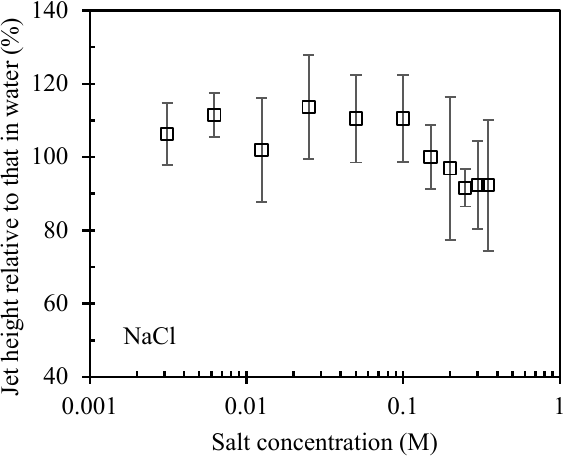
Figure 3. Maximum jet height in different salt solutions.